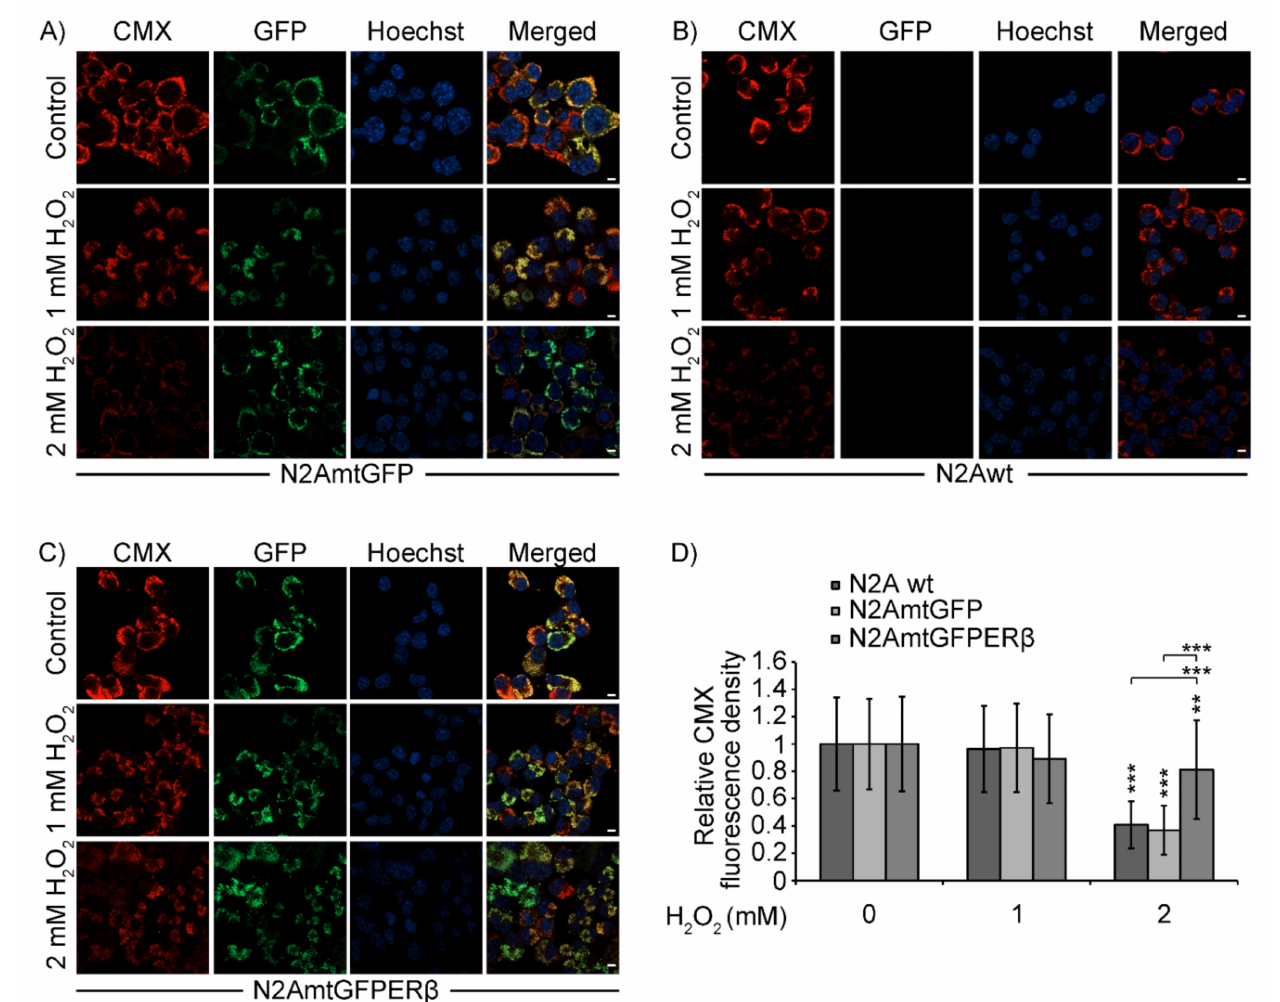
Figure 5. Effect of mtER β on H 2 O 2 -induced mitochondrial impairment in N2AmtGFP ( A ), N2Awt ( B ), and N2AmtGFPER β ( C ) cells. ( A – C ) Representative confocal microscopy single section images of GFP, CMX (mitochondrial staining) and Hoechst 33342 (nuclear staining). Bars indicate 10 µ m. ( D ) Quantification of the relative CMX fluorescence density. Data were analyzed by two-way ANOVA. Relative CMX fluorescence density was expressed as mean ± S.D. ( n = 30–50), ** p < 0.01, *** p < 0.001. CMX fluorescence density at vehicle treated N2A cells was set at 1. Vertical asterisks represent statistically significant differences compared to the respective vehicle treated cells of each cells line, while horizontal lines and the respective asterisks correspond to statistically significant differences between cells from different cell lines subjected to H 2 O 2 treatment, as